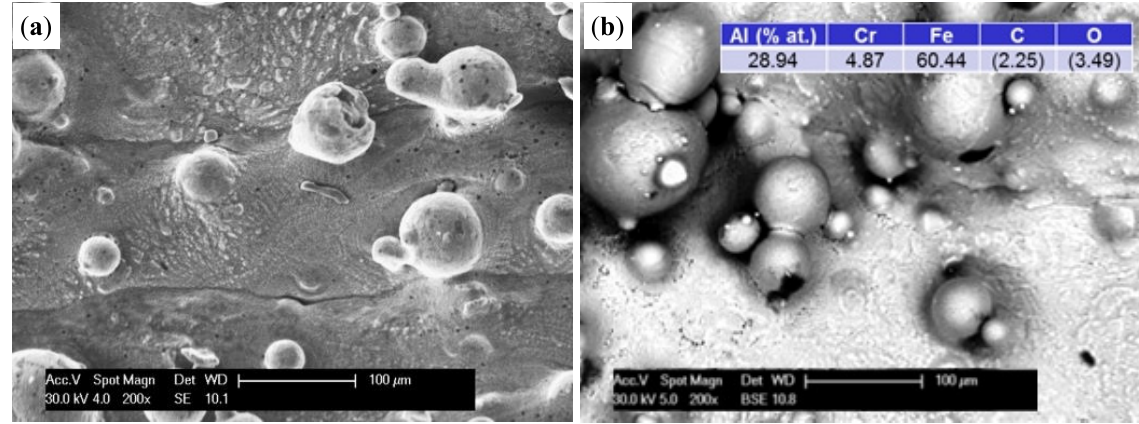
Figure 3. The morphology SE ( a ) and chemical composition BSE ( b ) of the surface of thin-walled prepared by LENS